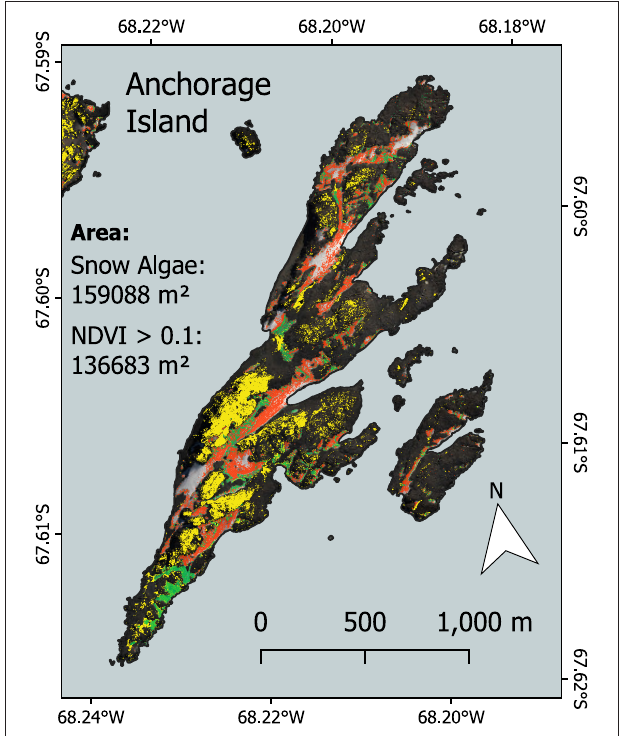
FIGURE 11 | Comparison between snow algal area and normalized difference vegetation index (NDVI) (a vegetation proxy) for Anchorage Island. Red and green pixels show the area covered by red and green snow algae, respectively. Yellow indicates pixels with an NDVI > 0.1, which indicates other vegetation (moss and